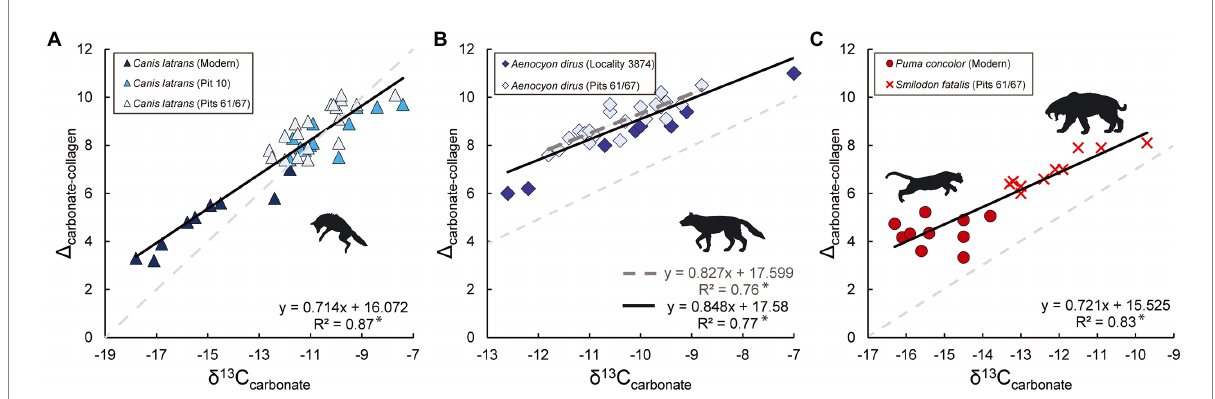
FIGURE 4 Relationships between δ 13 C carbonate values and Δ ca-co values for North American canid and felid specimens examined. Relationships between δ 13 C carbonate values and Δ ca-co values and in Canis latrans (A) , Aenocyon dirus (B) , and the felids ( C ; both Puma concolor and Smildon fatalis ). Black lines and subsequent regression equations and R 2 values reflect the inclusion of all data per taxon. The dark-gray dashed line in panel B denotes the regression line and equations specific to A. dirus based on δ 13 C collagen from bone collagen, while the solid black line includes δ 13 C collagen data from tooth dentin from A. dirus from Locality 3,874. A light-gray dashed-line with a slope of 1 is present in the background of each panel for reference. *denotes significant relationships ( p <